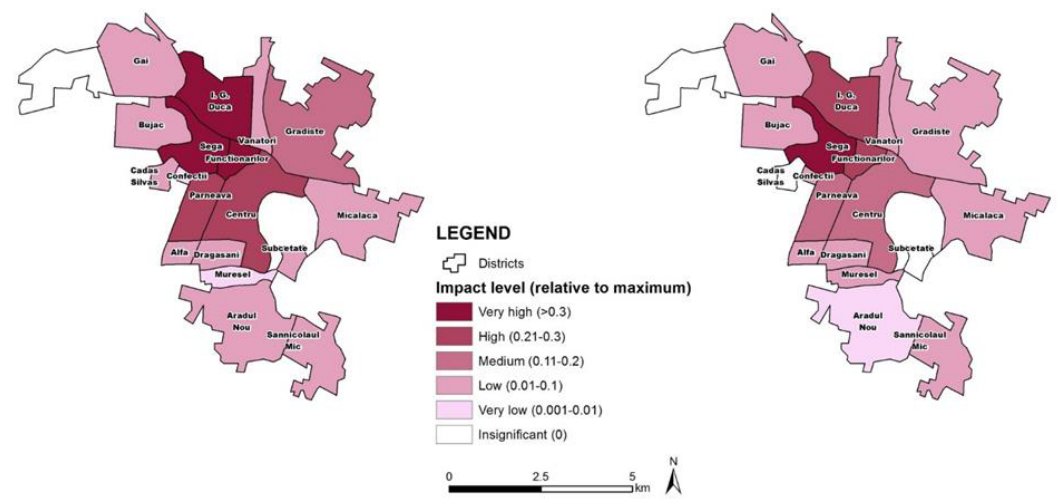
Figure 12. Impact mapping in the municipality of Arad (Romania) for day (left) and night time (right) [50].